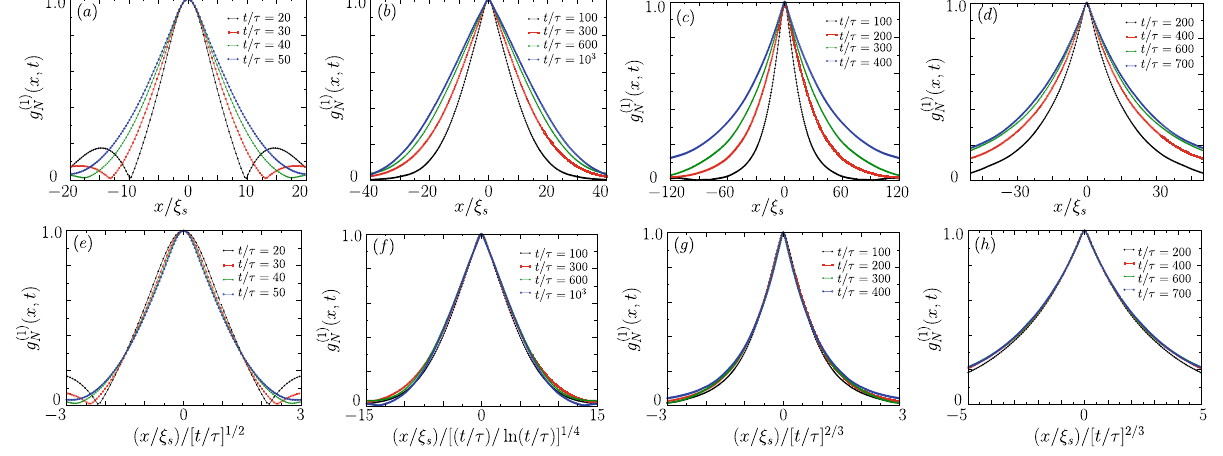
( 1 ) ( x , t ) at the given moment of time as indicated in Figure 3. Scaling of the correlation function g N ( 1 ) ( x , t ) while bottom panels the same when lengths are re-scaled by L ( t ), i.e. legend. Upper panels show g N 0.75 and M / N 0.5 are shown for short times where the scaling ( x / L ( t ) , t ) . In (a) and (e) results for q g ( 1 ) N = = L ( t ) t 1 / 2 is temporally observed. In (b) and (f) are the same parameters but in the long time limit when ∼ 0 are shown where we recognized 0.5 and M ( t / ln ( t )) 1 / 4 is realized. In (c) and (g) the results for q L ( t ) = = ∼ 0 is shown where the scaling hypothesis works the 1.25 and M L ( t ) t 2 / 3 . Finally, in (d) and (h) data for q = = ∼ t 2 / 3 best with L ( t ) ∼